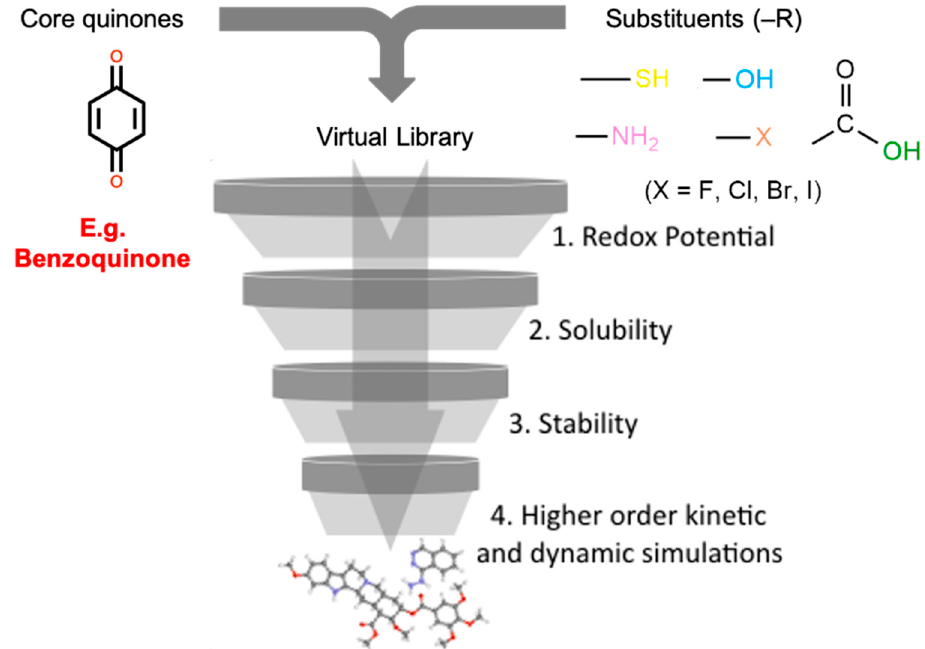
Figure 2. Schematic diagram of the typical implementation of an HTVS of quinones with sequential funnels associated with performance descriptors.